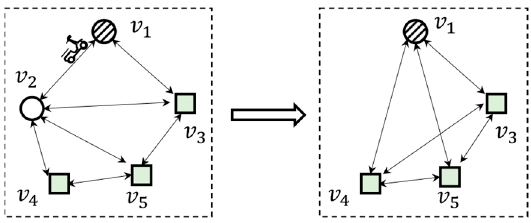
Figure 5. Vertex subgraph diagram.